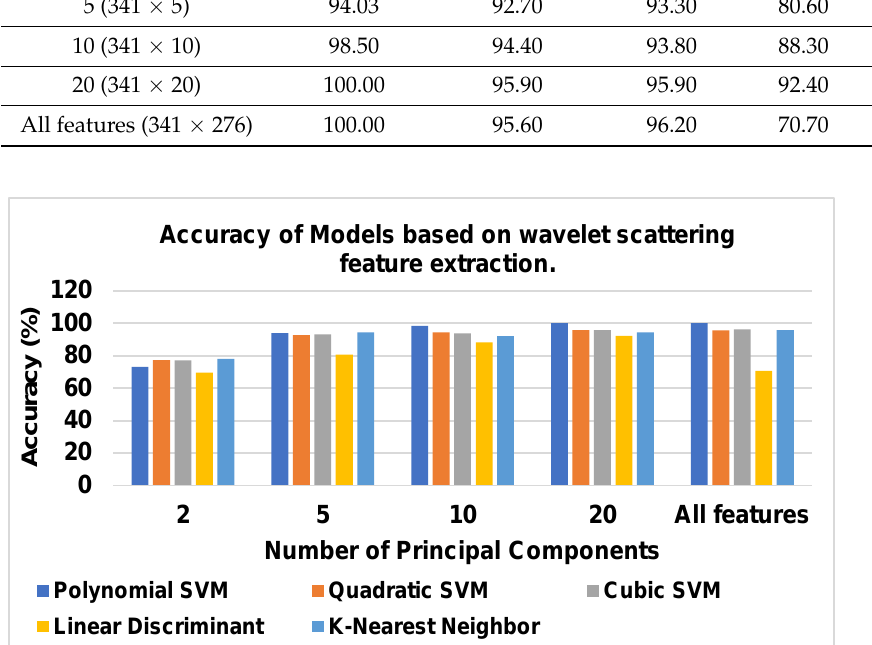
Figure 7. Accuracy of models based on wavelet scattering feature extraction.